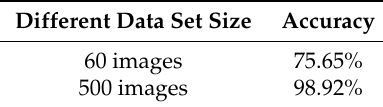
Table 1. The influence of the data